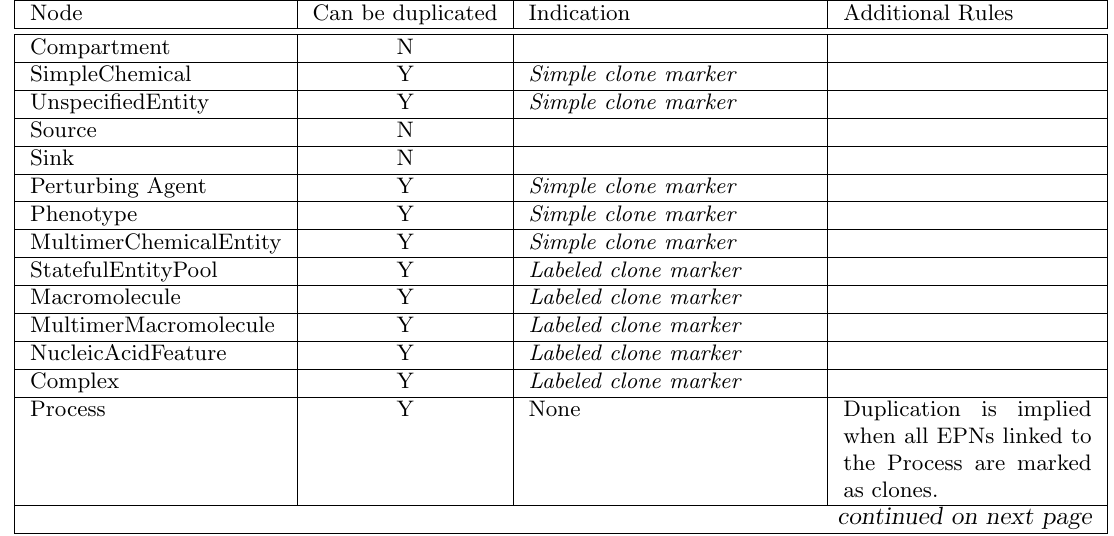
Table 3.2: Duplication